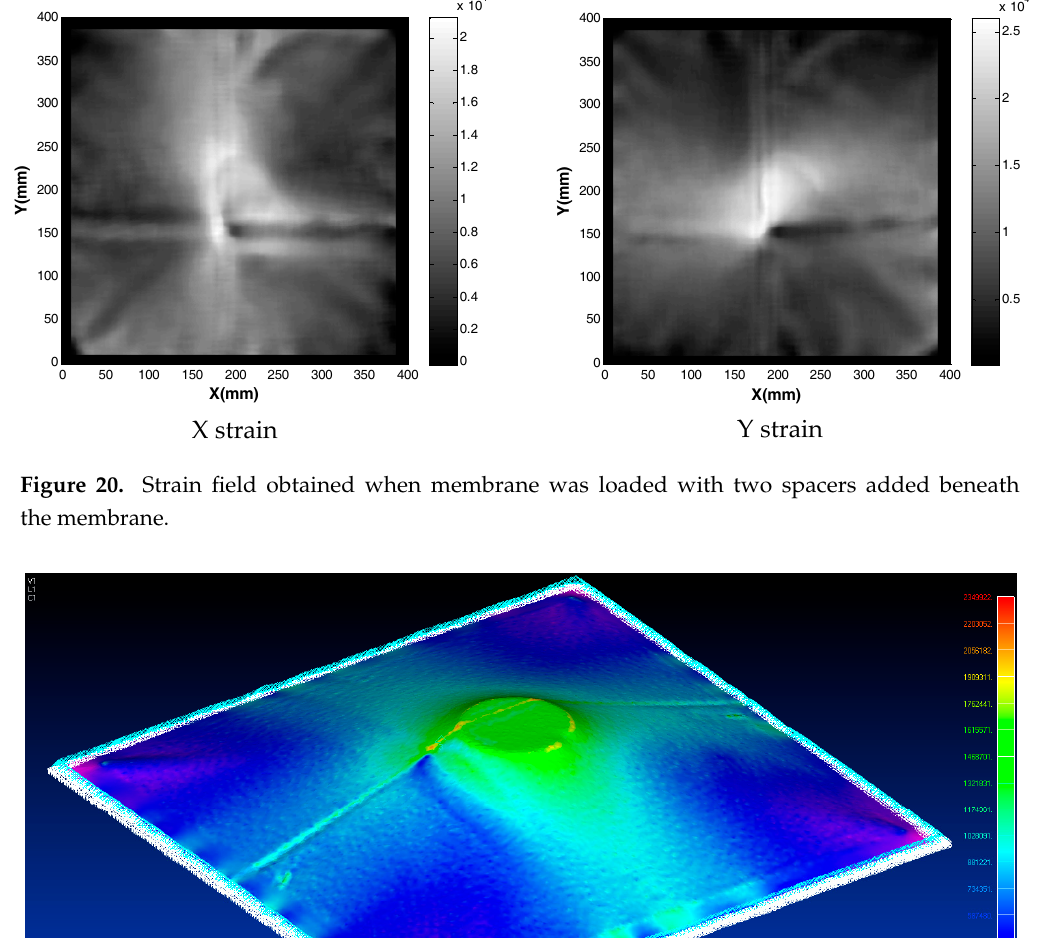
Figure 21. The von Mises stress distribution with three spacers placed beneath the membrane.